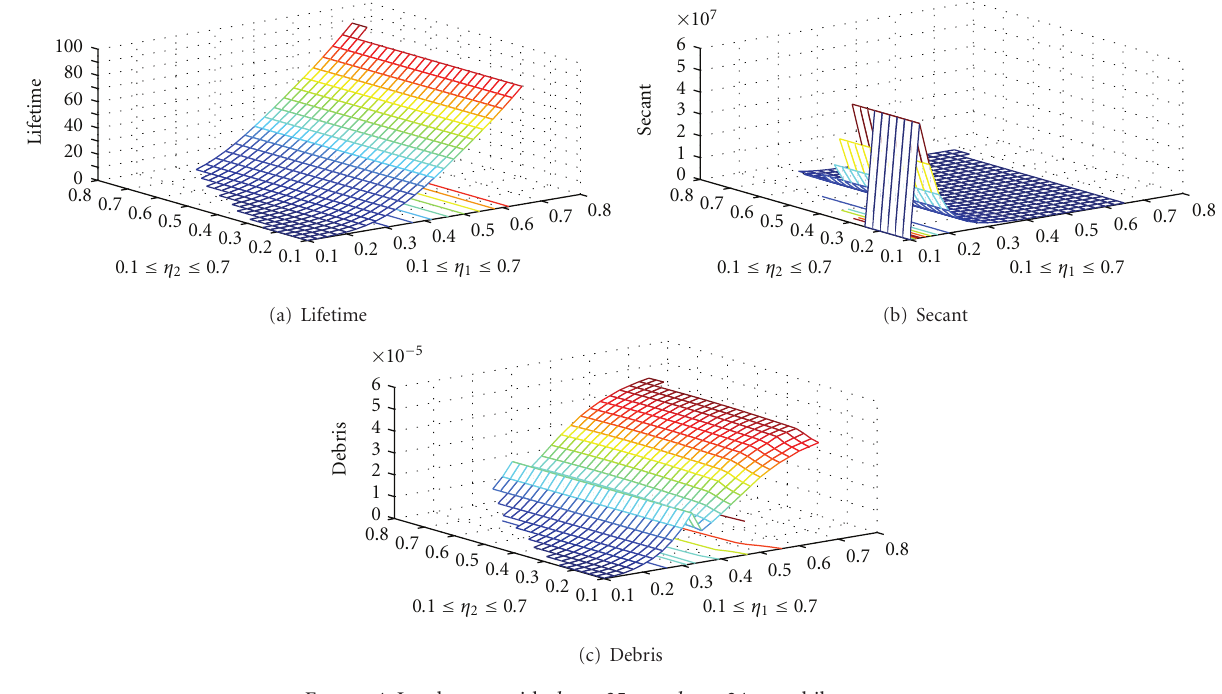
Figure 4: Landscapes with d p 1 = 35 μ m, d p 2 = 24 μ m while η 1 , η 2 vary.